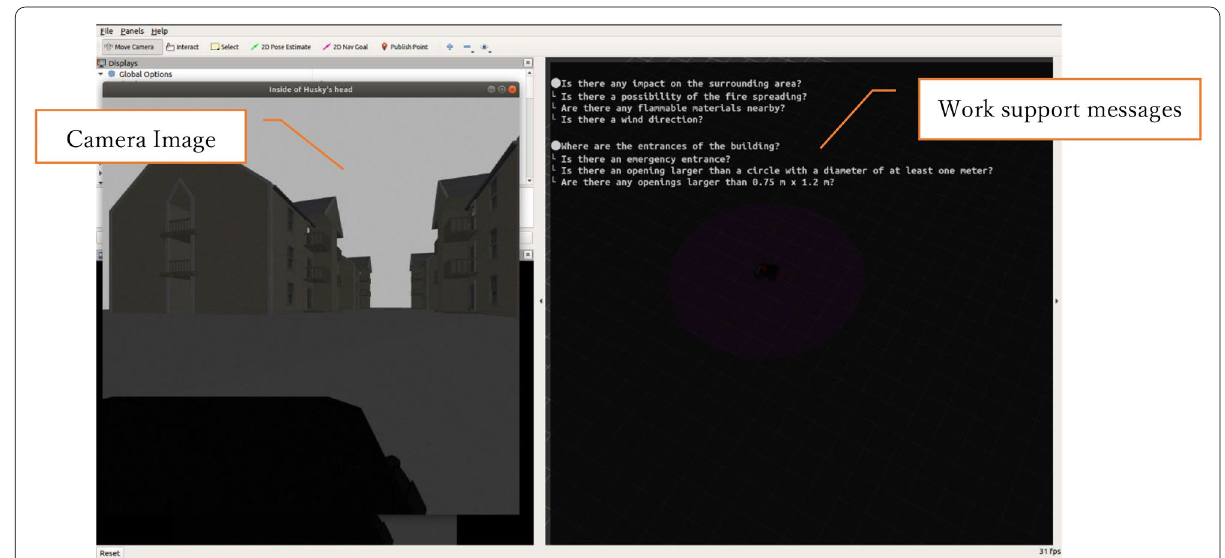
Fig. 7 Operation screen of the